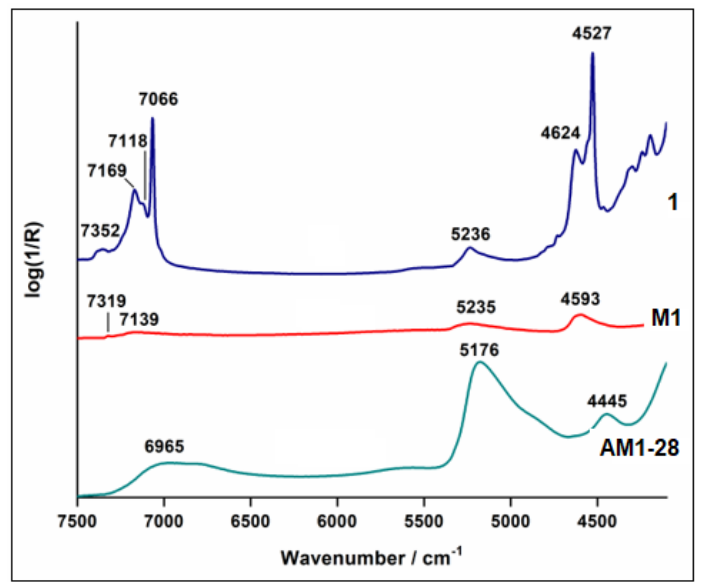
Figure 5. NIR spectra of: kaolin 1, metakaolin M1 and alkali-activated AM1-28. Creation of new phases because of the kaolins’ dissolution in NaOH also affects the shape of the NIR spectrum of AM1-28. Broad bands at 6965 cm − 1 corresponding to the 2 ν H 2 O overtone and at 5176 cm − 1 due to the ( ν + δ )H 2 O combination mode reflect the